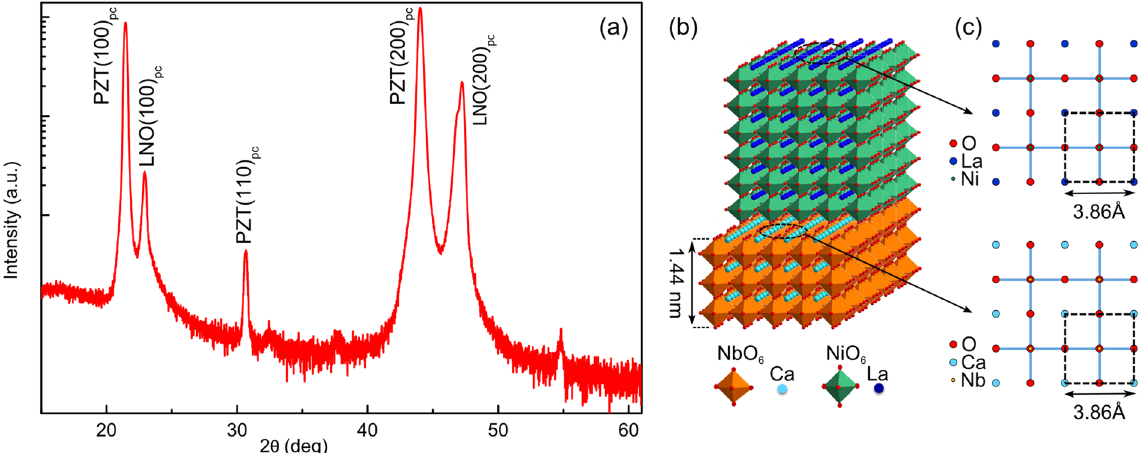
Figure 1. Crystal structure of the H 20Hz heterostructure. ( a ) XRD θ –2 θ scan. ( b ) Polyhedral representation of LaNiO